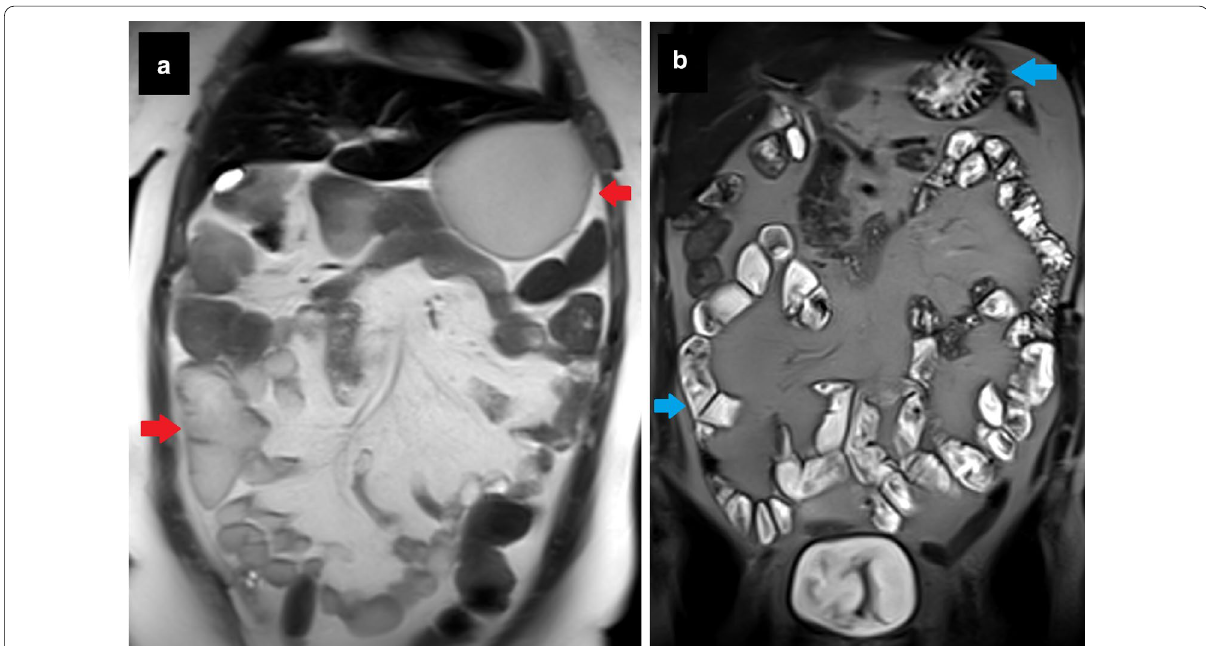
Fig. 21 A technique error causing unnecessary effort. A 47-year-old female patient was investigated for inflammatory bowel disease, and MRI enterography was ordered. Before the procedure, the patient had drunk the gadolinium-containing contrast agent in the radiology department by mistake. Due to the paramagnetic feature of gadolinium, the required image quality for evaluation of the intestinal lumen could not be achieved. The MRI technician realized the problem and immediately informed the radiologist. After the radiologist’s evaluation, the study was rescheduled. Although the technical error caused unnecessary effort (repeated examination) in this case, the effective communication between the radiologist and MRI technician enabled them to recognize and correct the error earlier (red arrows, a intestinal lumen with gadolinium, blue arrows, b